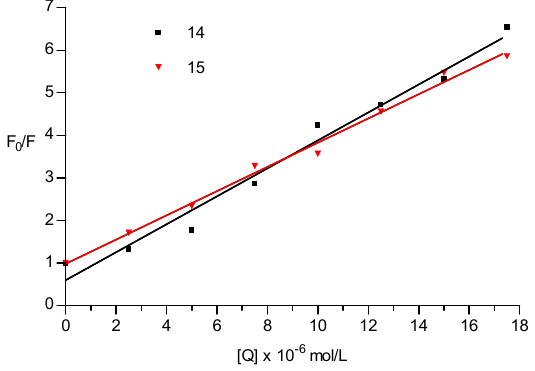
Figure 6. Stern-Volmer plots of BSA (1.00 × 10 − 5 mol L − 1 ) quenched by CM14 and CM15 at 22 °C. Table 3. Excitation and emission maxima of CM14 and CM15 , and the quenching constant of BSA by CM14 and CM15 .